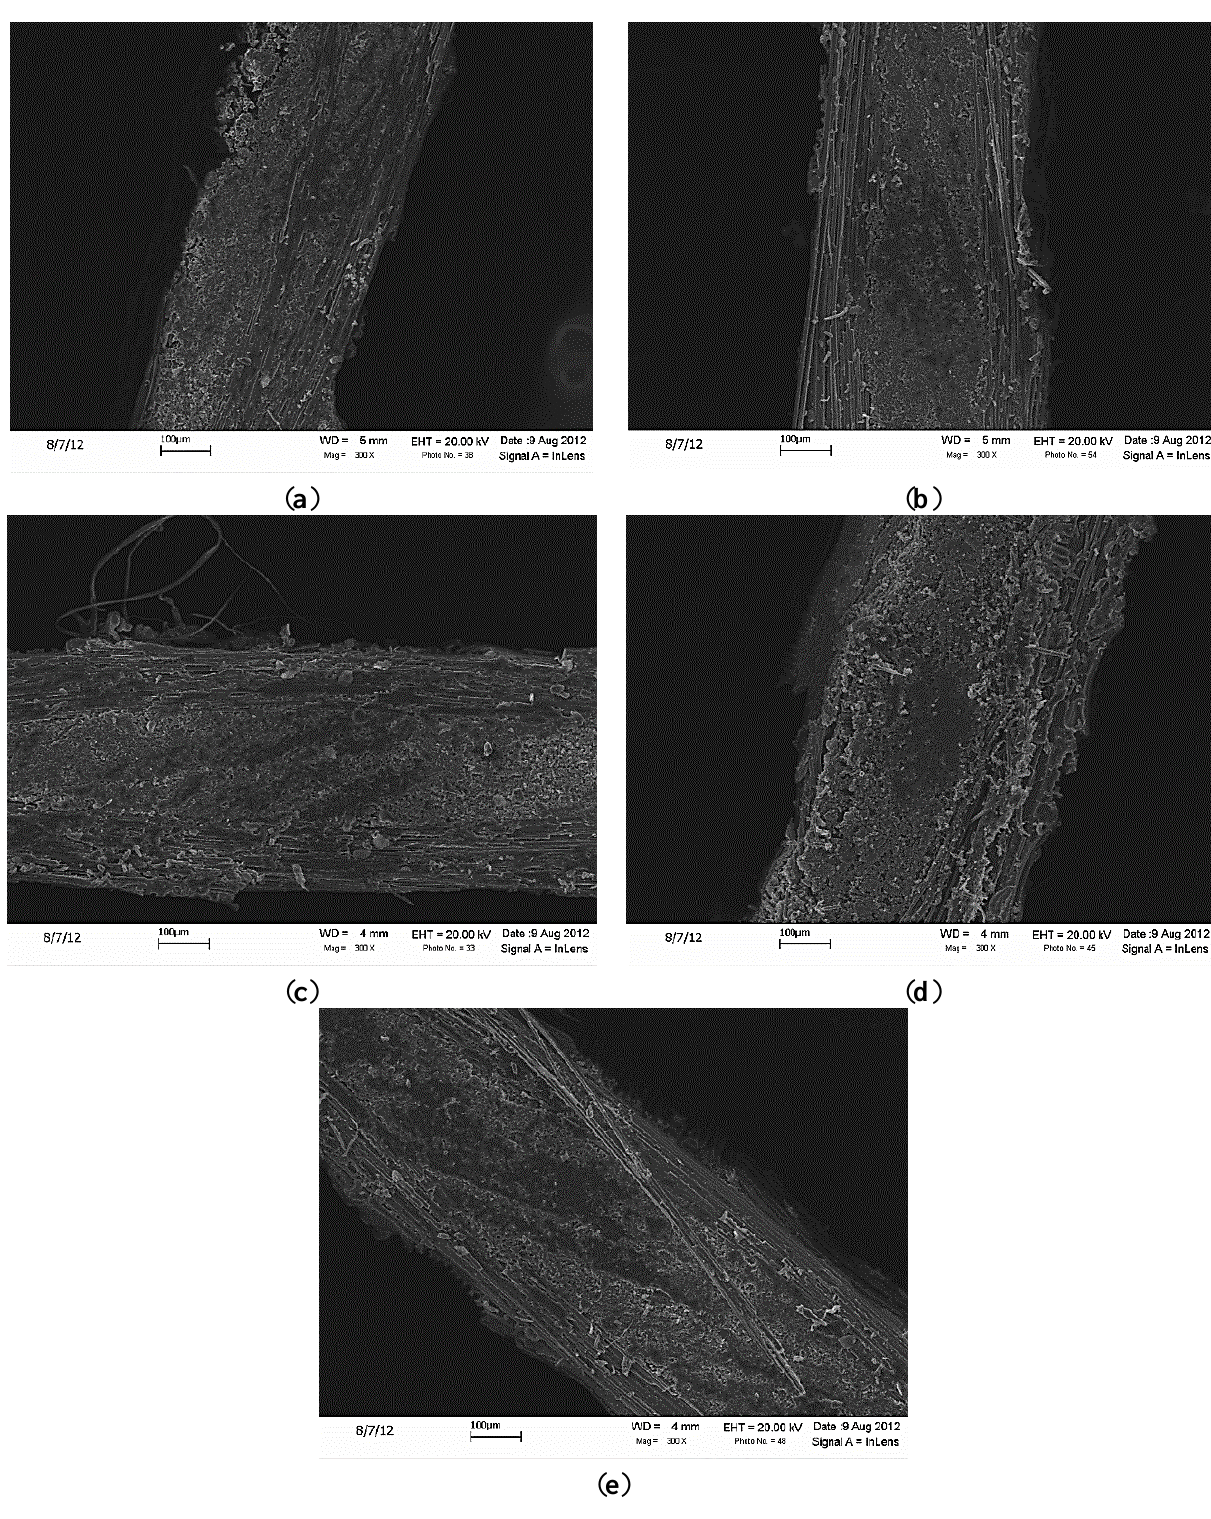
Figure 7. The cross-sections of all fabricated composite samples were investigated under scanning electron microscopy (SEM). The cross-sectional images of all samples, as well as the magnified images for the GSD and CCVD samples are shown below. The SEM micrographs show the same level of matrix penetration for all samples. ( a ) R; ( b ) R + HT; ( c ) Sp + HT; ( d ) GSD; ( e )